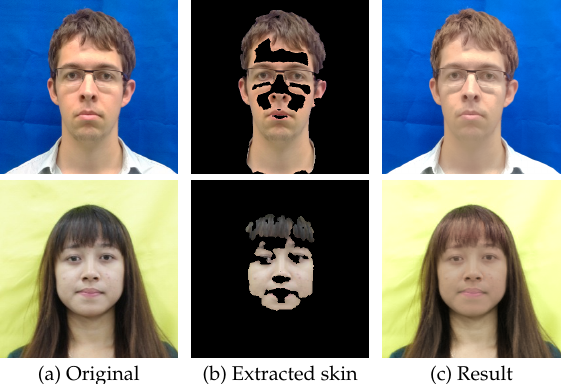
Figure 16. Bad results of our method due to the skin color extraction phase. In the original image the face and hair are a similar color. The target image is the image used in Figure